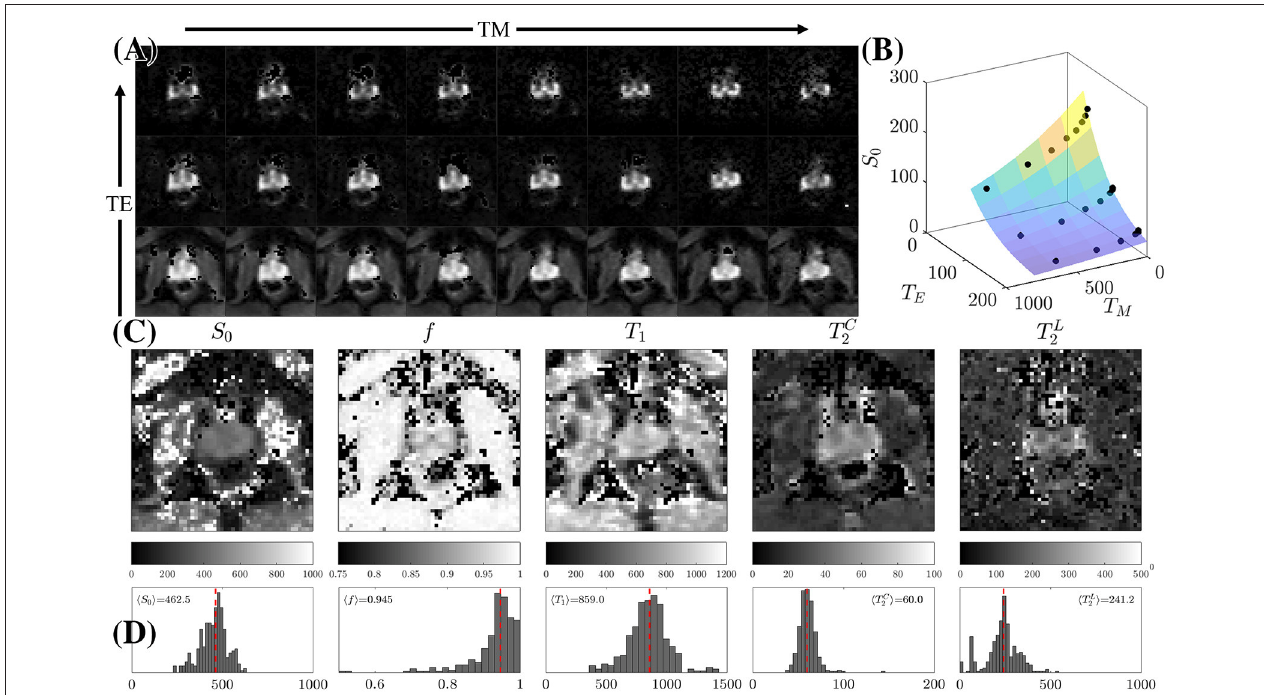
FIGURE 5 | STEAM Relaxometry. (A) Echo time ( T E ) and mixing time ( T M ) dependence of the non-diffusion-weighted dMRI signal, S suppression of the majority of tissues at long T E . (B) Fitting Equation (8) to S parameters: the proton density S 0 , overall T 1 , cellular compartment fraction, f , fast (cellular) T C 2 , and slow (luminal) T L 2 . (D) Histograms displaying the distribution of relaxation parameters on all 3 volunteers within PZ only. The dashed line is the mean parameter derived from TABLE 1 | The mean and standard deviation over a PZ ROI is shown for the relaxation parameters derived from S